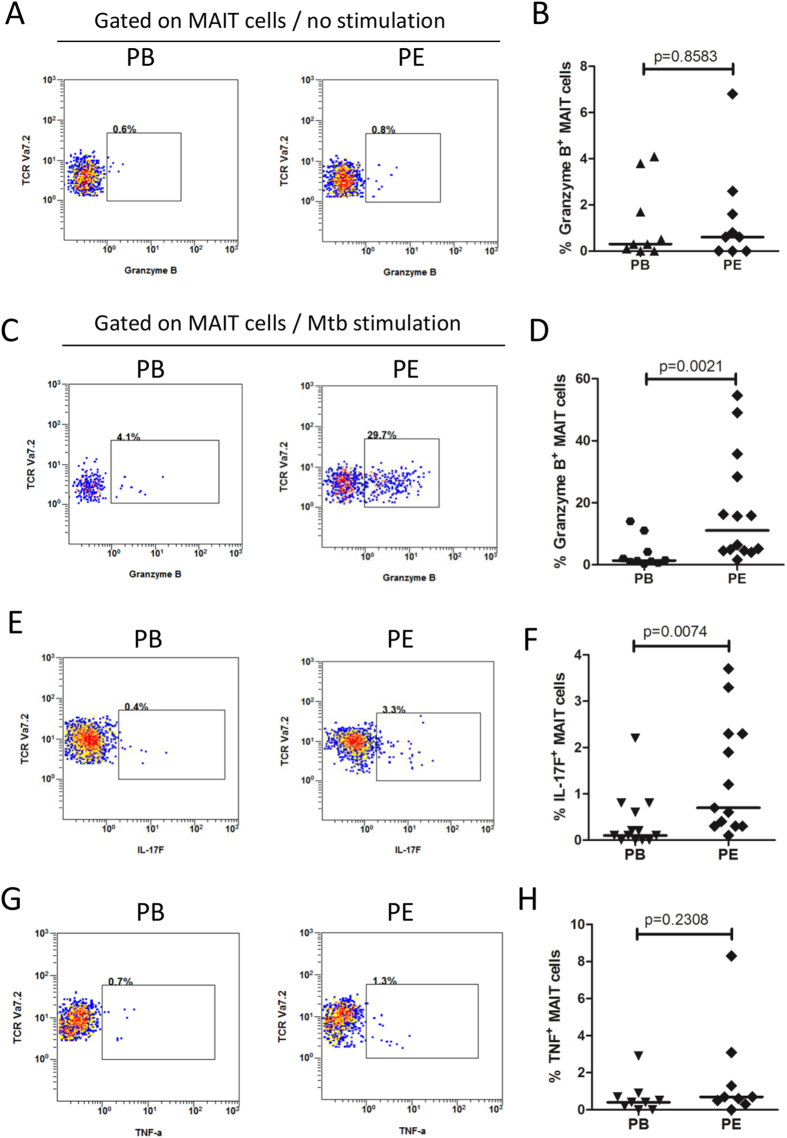
Expression of granzyme B, IL-17F and TNF-α in MAIT cells.(A) Representative flow plots showing expression of granzyme B in MAIT cells from peripheral blood (PB) and tuberculous pleural effusion (PE) in the absence of antigen stimulation. (B) MAIT cells from tuberculous pleural effusions had similar expression of granzyme B compared with those from peripheral blood in the absence of antigen stimulation. (C) Representative flow plots showing expression of granzyme B in MAIT cells from peripheral blood (PB) and tuberculous pleural effusion (PE) after Mtb antigen stimulation. (D) MAIT cells from tuberculous pleural effusions had much higher expression of granzyme B than those from peripheral blood after stimulation with Mtb lysates. (E) Representative flow plots showing expression of IL-17F in MAIT cells from peripheral blood (PB) and tuberculous pleural effusion (PE) after Mtb antigen stimulation. (F) MAIT cells from tuberculous pleural effusions had significantly higher expression of IL-17F than from peripheral blood. (G) Representative flow plots showing expression of TNF-α in MAIT cells. (H) TNF-α expression in MAIT cells did not show significant difference between the two groups. Horizontal bars in the scatter plots indicate medians. The nonparametric Mann-Whitney test was used for statistical analysis between groups in Fig. 2B,D,F,H.